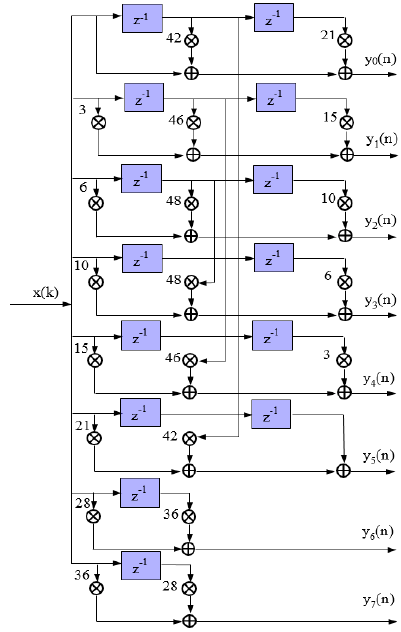
Figure 2. The structure of simplified 8× interpolation CIC filter parallel algorithm.